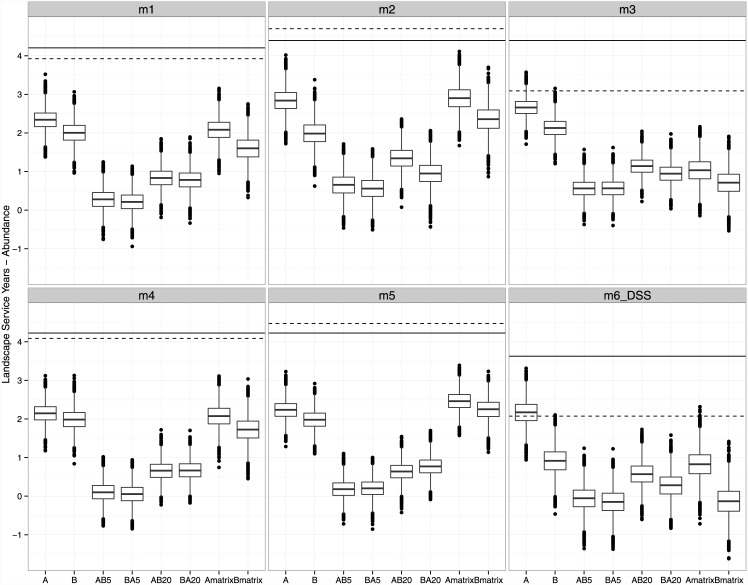
Landscape Service Years for abundance (N).Solid horizontal line represents the number of credits available in the bank, prior to a trade, assuming a static matrix and the dashed horizontal line is the number of credits available under a declining matrix. Boxplots of bootstrapped credit values remaining after each trade, with bars represent median values, the box represents the upper and lower 25th quartile, whiskers represent max/min values excluding outliers, and dots represent outliers, or values 1.5 x 25th quartile.